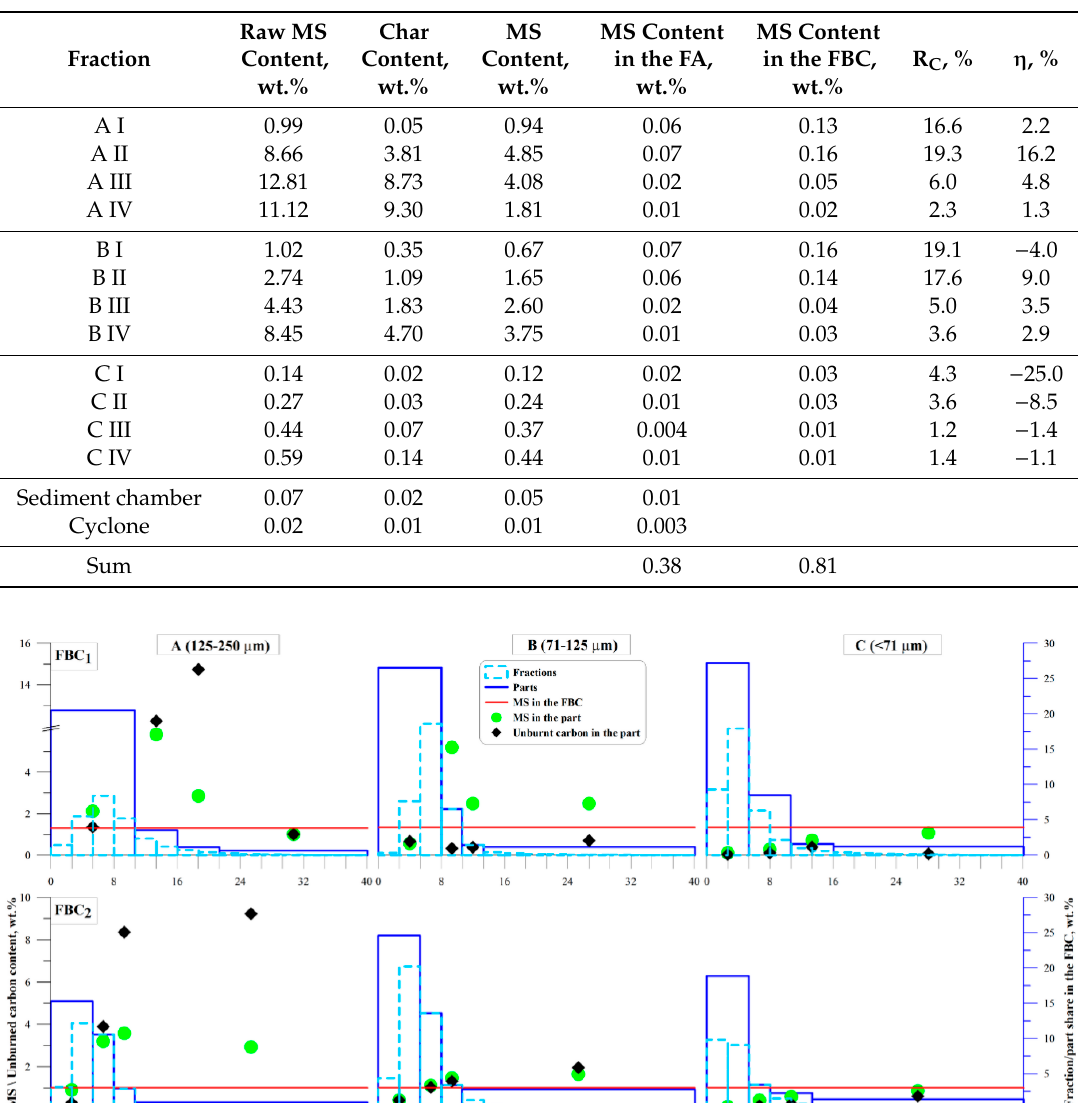
Table 5. The MS content in the fly ash FA 3 fractions.